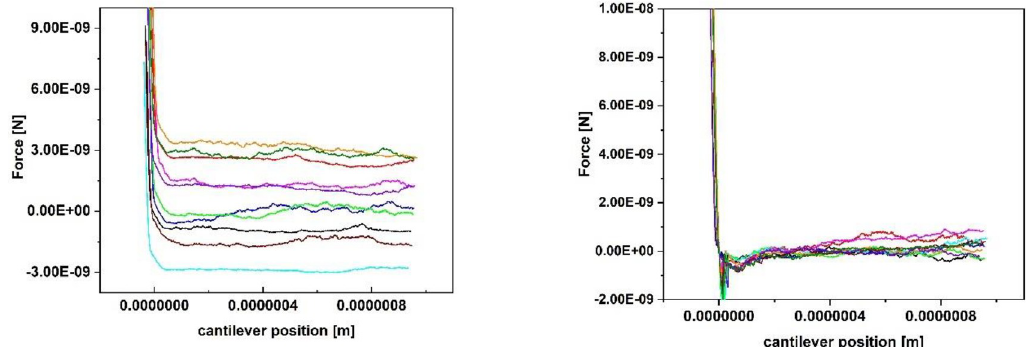
Fig 4. 10 typical force-distance curves (left trace, right retrace. The baseline of all the retrace curves was set to 0 nN) of a single Lactococcus lactis cell on glass, recorded with the following parameters: Setpoint 10 nN, z-length 1 μ m, z-speed 2 μ m/ s, pause time 10 s.